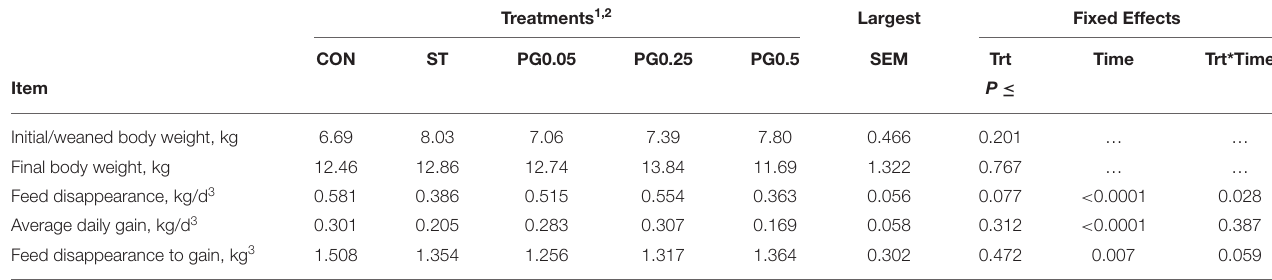
TABLE 2 | Performance effects of a ceramic particle fed to pigs after a Salmonella enterica serotype typhimurium